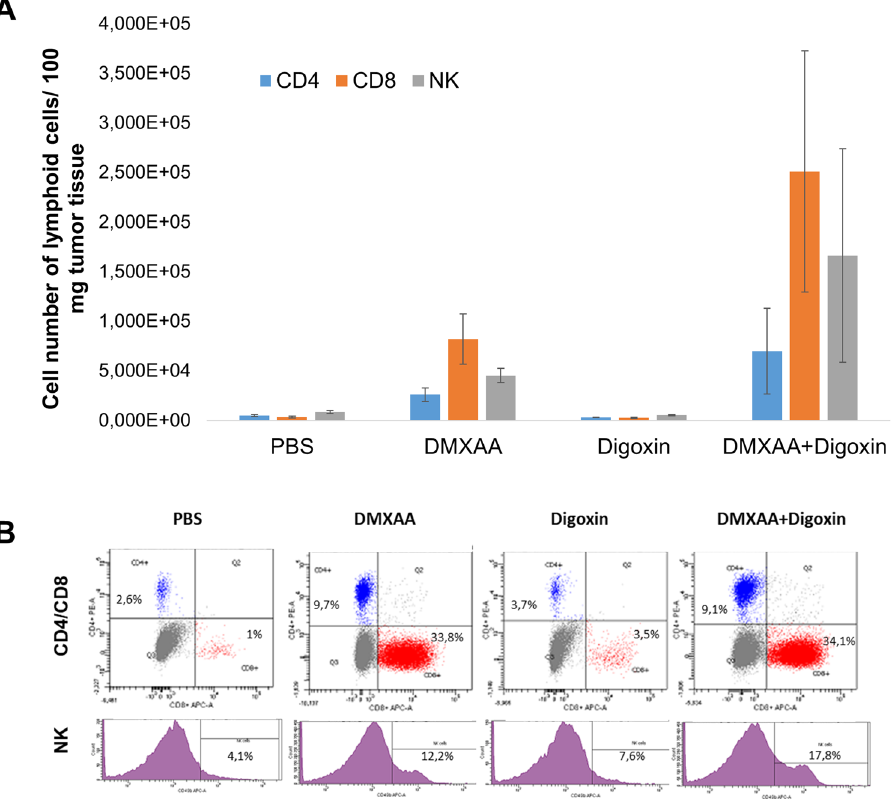
Figure 6. Presence of immune cells in murine melanoma after administration of DMXAA and digoxin. DMXAA alone and the combination of DMXAA with digoxin increase the levels of CD8 + lymphocytes, NK cells and to a lesser extent CD4 + lymphocytes ( A ). Digoxin alone does not change CD8 + , CD4 + , NK cells contribution comparing to control (PBS − ). Representative plots of cytometric analysis ( B ).